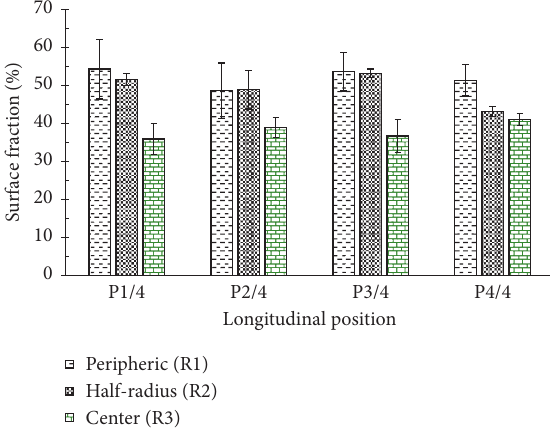
Figure 3: Synthesis of surface fractions of RV fibers along the RV